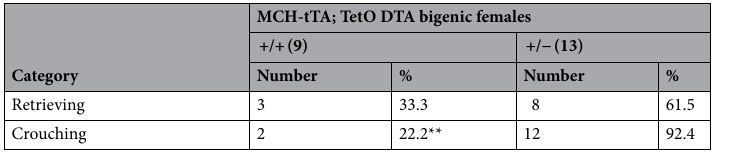
Table 1. Number and percentage of MCH-tTA; TetO DTA bigenic females in each response category. ** p < 0.01, Chi-square test with Bonferroni post hoc analysis, different from +/− females.